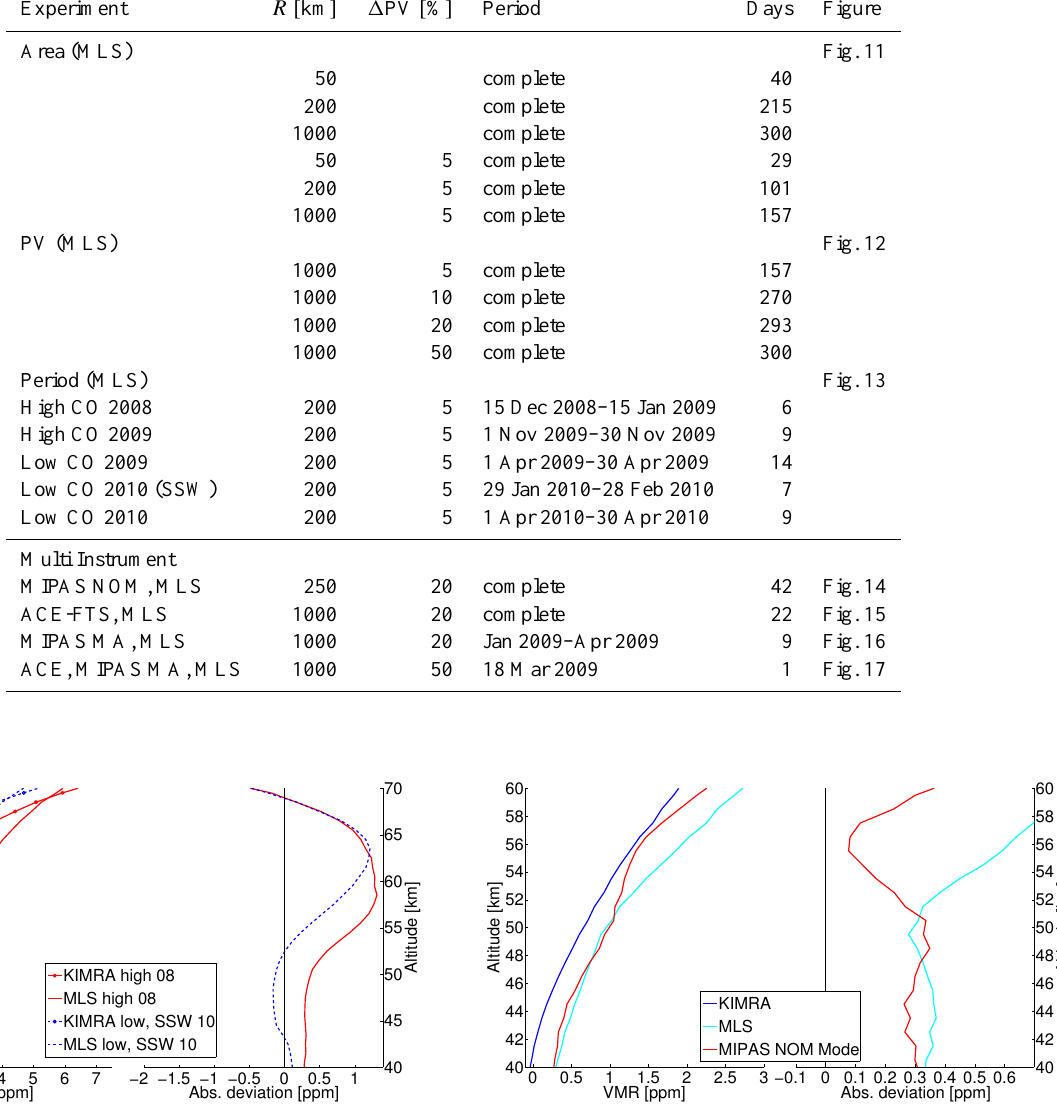
Fig. 13. Investigation of the influence of the averaged period using the MLS dataset in a constant radius of R =200km. Two cases with comparatively high (red) or low (blue) CO values are shown. Three more cases were analyzed but are not shown for clarity of the figure; for details see Table 5. Left panel: mean profiles derived according to Sect. 5.1. Right panel: deviation between the KIMRA and the satellite profiles calculated with Eq. (20).